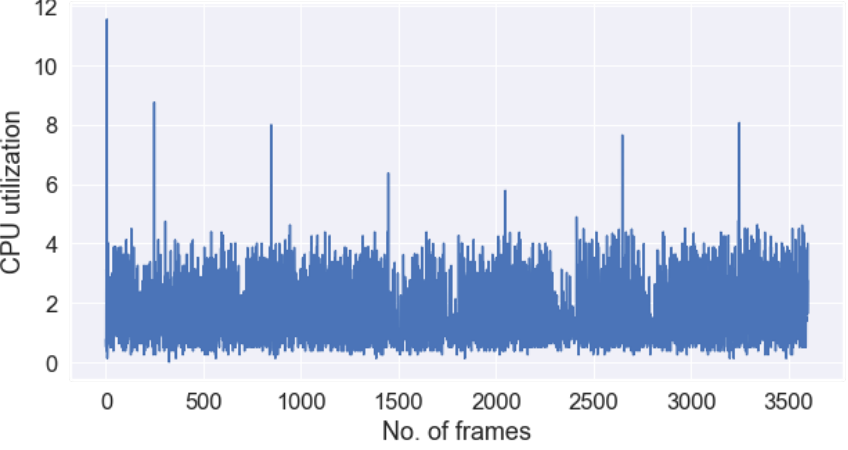
Figure 21. CPU utilization in